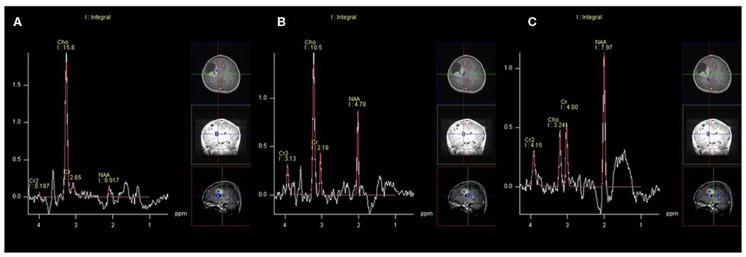
A 12-year-old man with supratentorial intraparenchymal anaplastic ependymoma in the right frontal lobe on magnetic resonance spectroscopy (MRS). (A) The tumor shows increased choline (Cho)/creatine (Cr) and marked decreased N-acetyl-aspartate (NAA), (B) peritumoral area regions of interest (ROIs) display increased Cho/Cr and moderate decreased NAA, and (C) compared to the normal-appearing white matter.